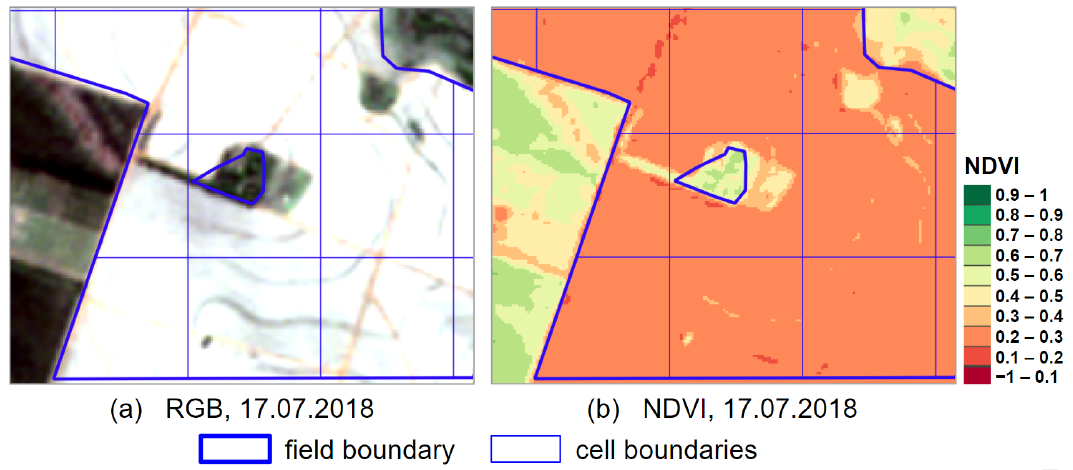
Figure 20. Example of the sugarcane field fragment with the included nonagricultural lands (cid = 40) in natural colours ( a ) and NDVI ( b ).